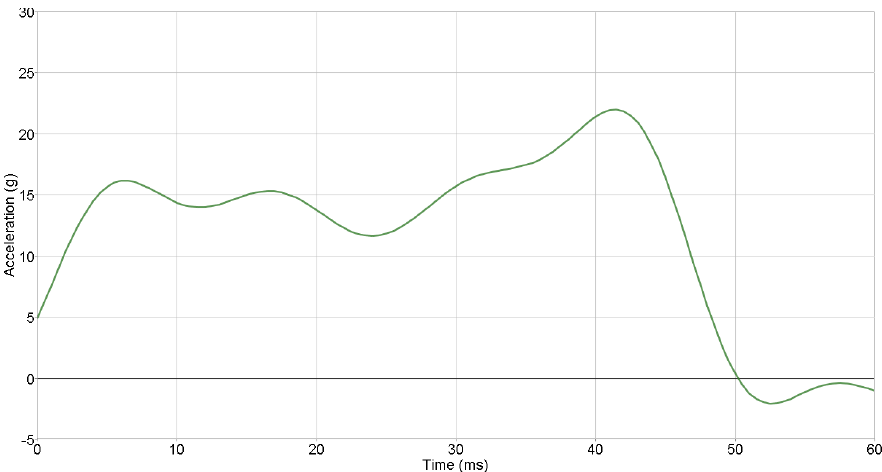
Figure 10. Acceleration of the impact block filtered with a CFC 100 Hz filter for the model with the front part of the chassis.